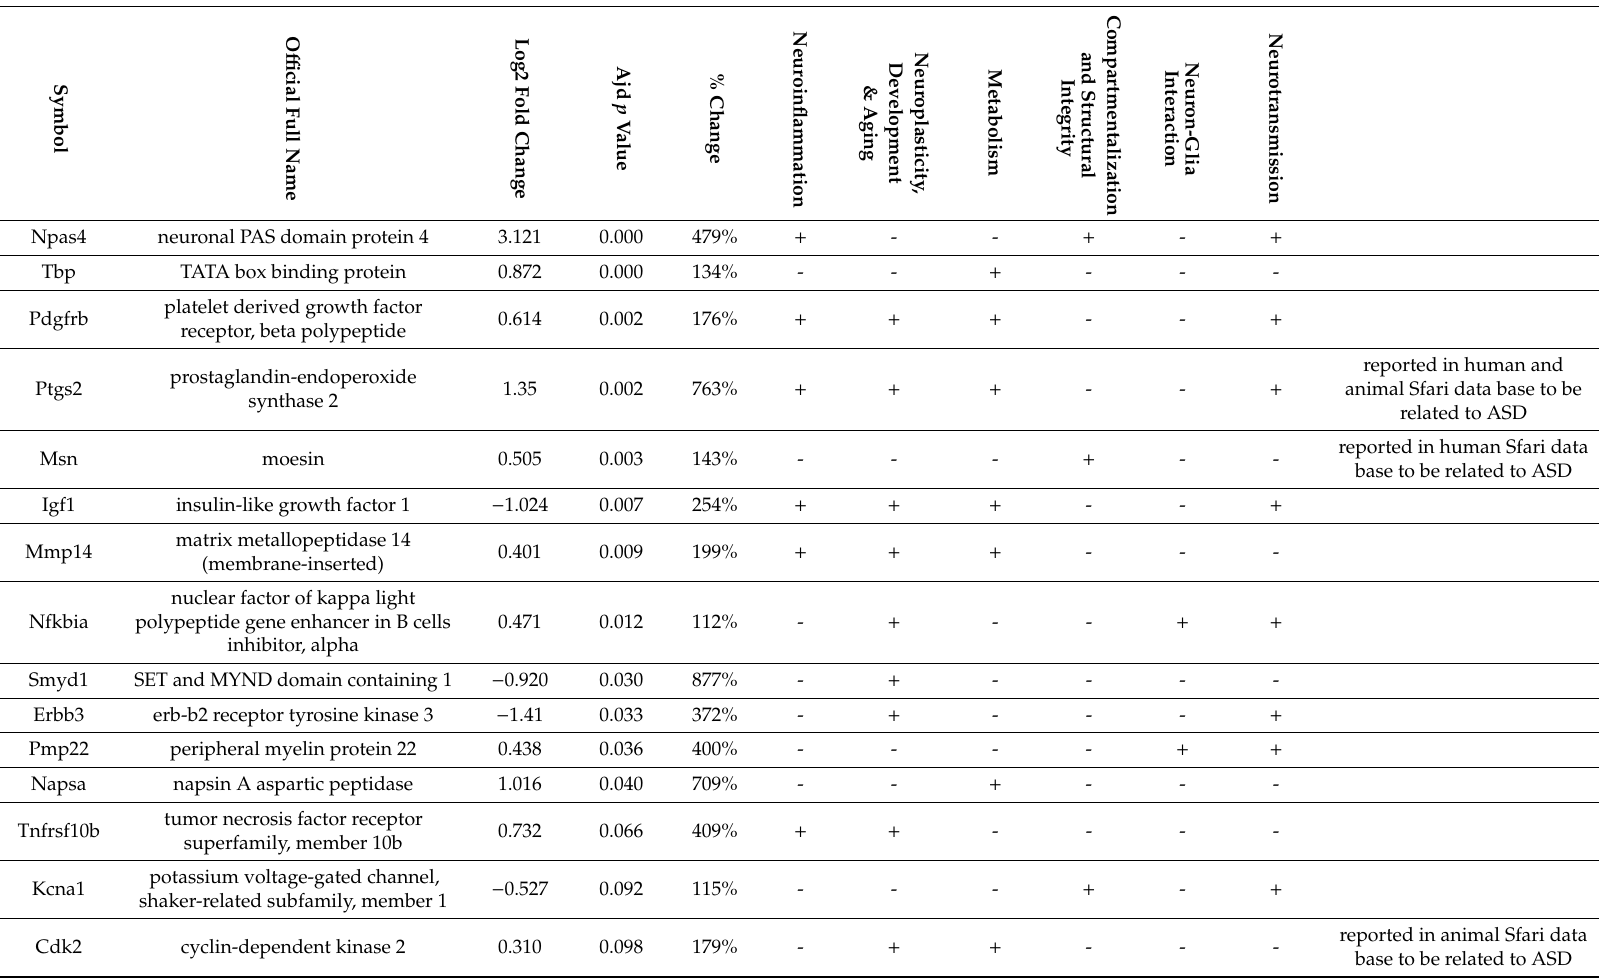
Table 2. Genes significantly changed at least by 100% in females after SAMe